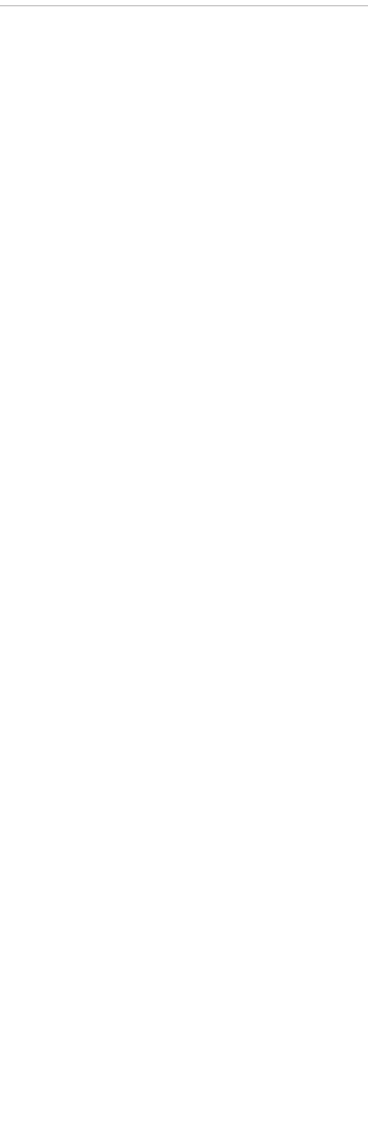
FIGURE 1 | Quanti fi cation of S. epidermidis 1457 bio fi lms formed under VBNC conditions. (A) Total amount of cells (OD 640 nm ); (B) Live cells (cells/mL) and (C) Culturable cells (CFU/mL). The results are displayed as the mean + standard deviation of at least six independent experiments. *** p < 0.001 (One-way ANOVA). PRE, prevented; IND,